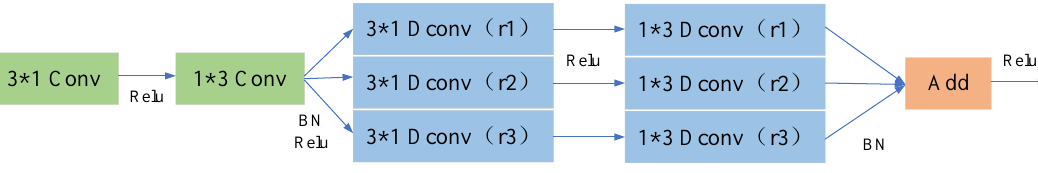
Figure 8. The structure of PFCU. The specific structures of the bottleneck residual block, non-bottleneck residual block, one-dimensional non-bottleneck residual block and FCU in ResNet are shown in Figure 9.